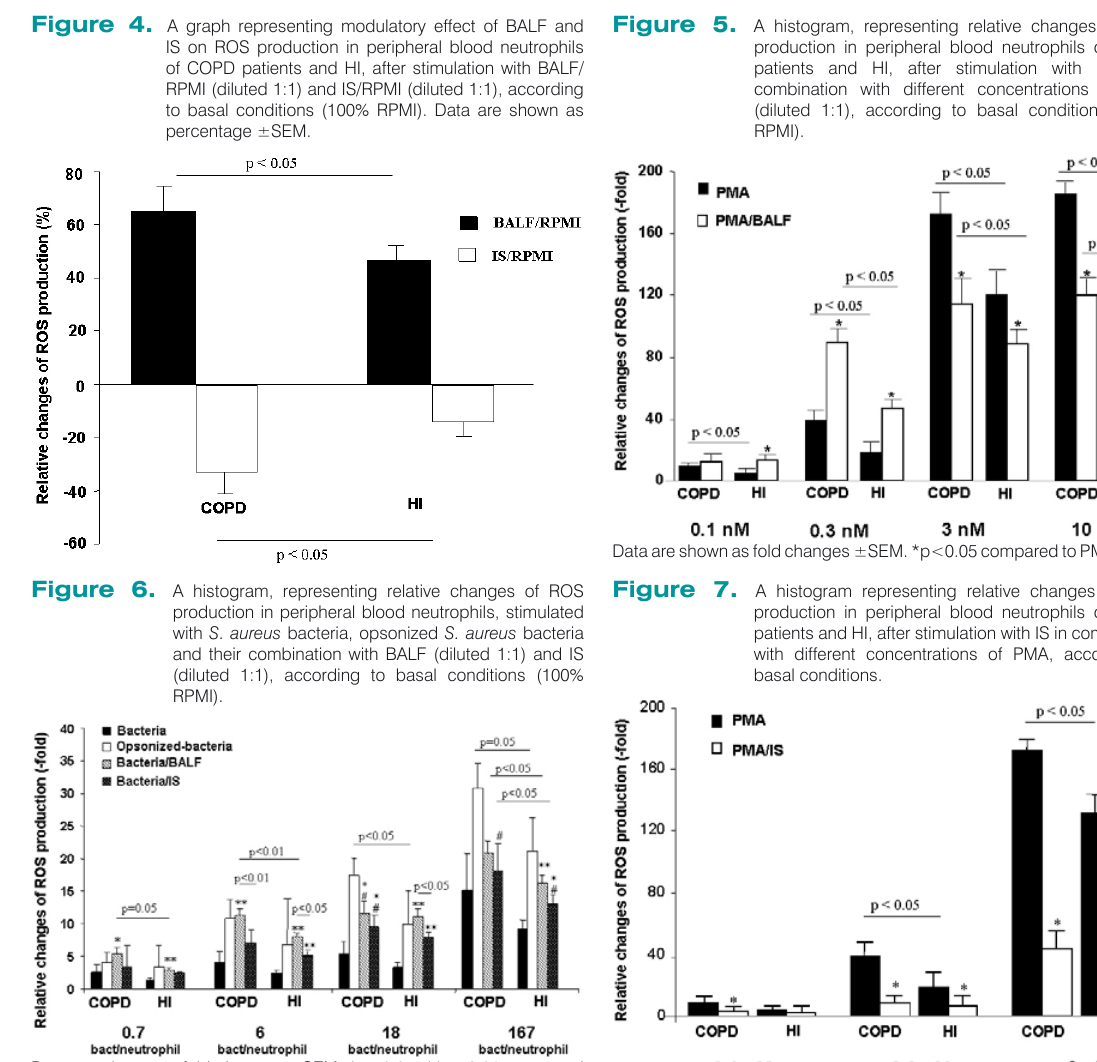
Data are shown as fold changes ±SEM. *p<0.05, **p<0.01 compared to non-opsonized S. aureus bacteria, #p<0.05, ##p<0.01 compared to